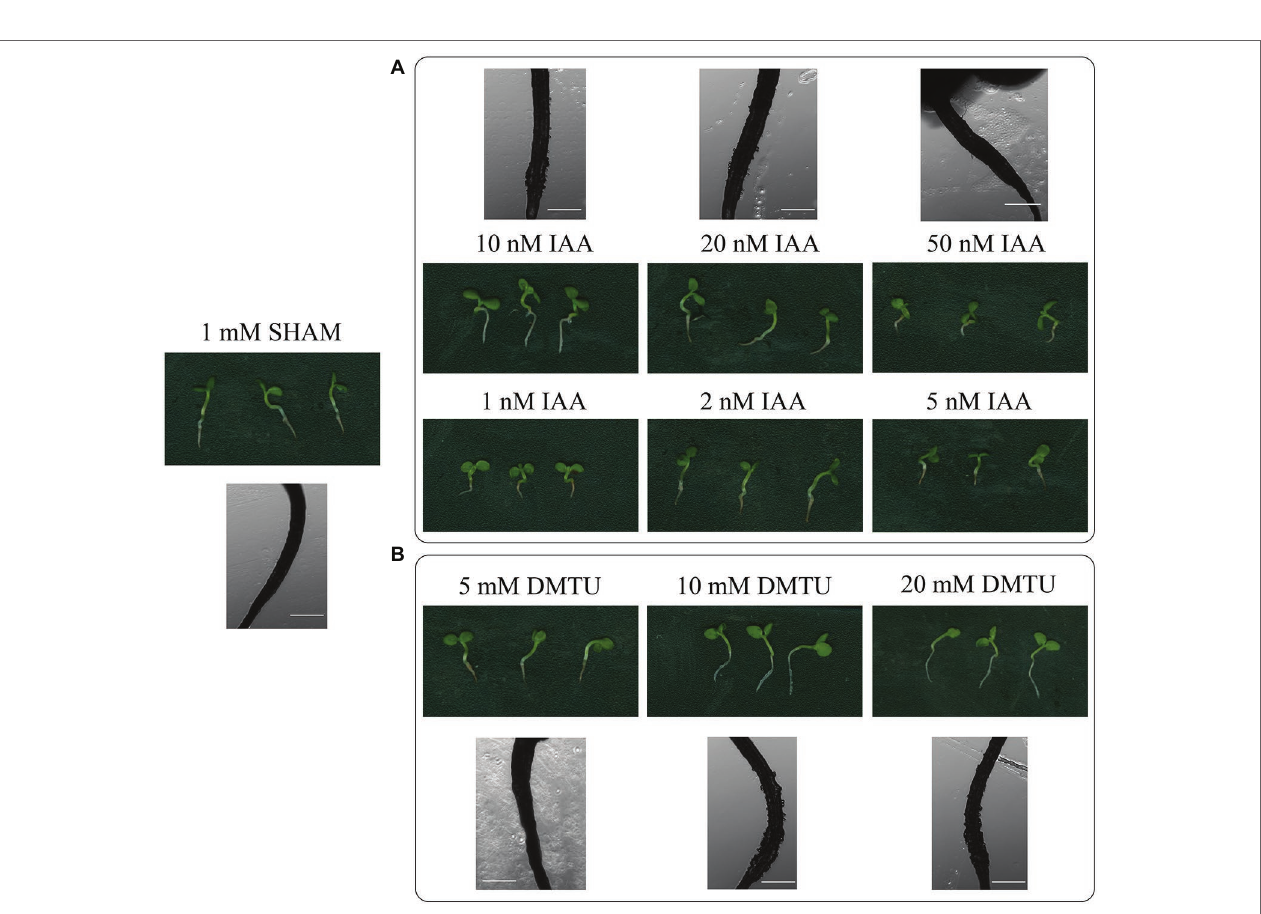
FIGURE 11 | Effects of adding indoleacetic acid (IAA) and dimethylthiourea (DMTU) on the root development of SHAM treatment. The root development on the 8th day of samples treated with 1 mM SHAM and treated with SHAM plus different concentrations of IAA (A) and DMTU (B) are shown. In addition, the representative root hairs were observed with a microscope. Scale bar, 500 μ